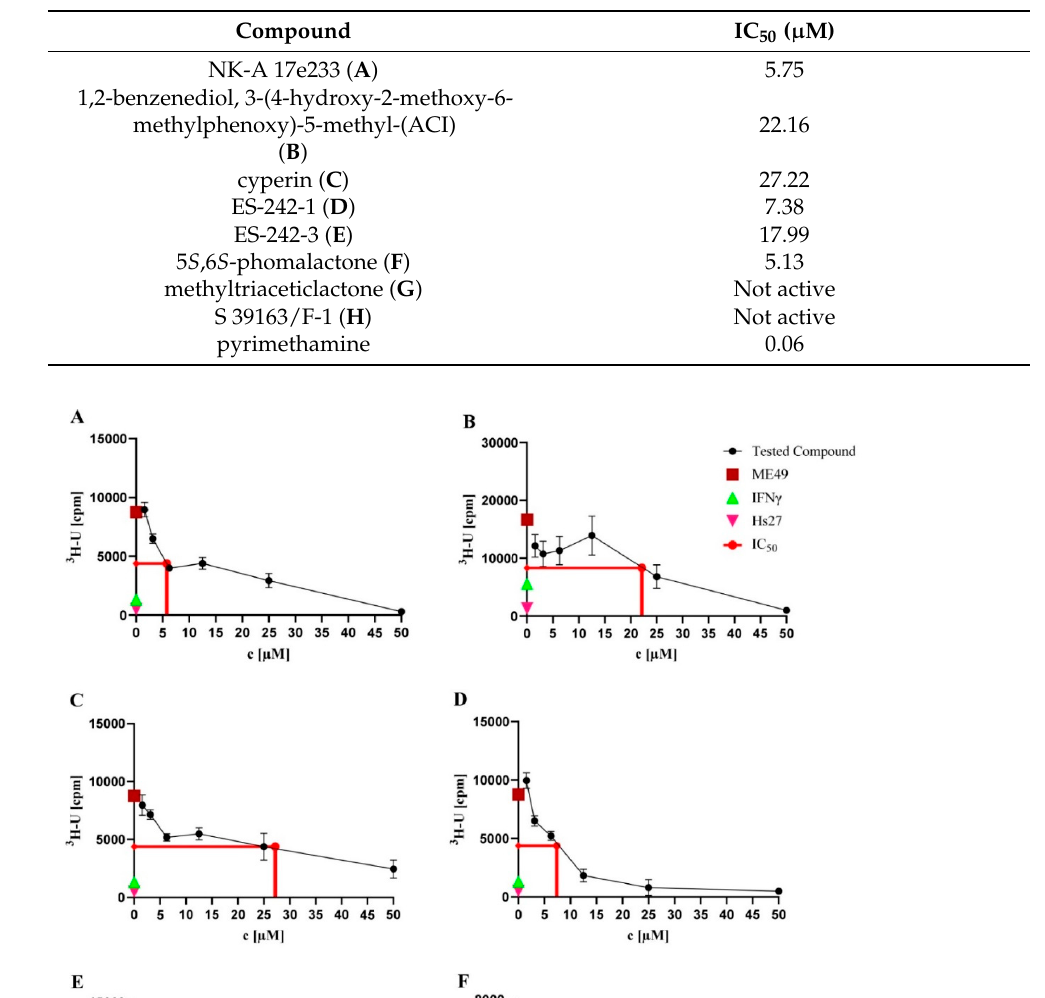
Table 1. In vitro activity (IC 50 values) of the natural compounds ( A – H ) from P. selaginellae against the T. gondii strain ME49. All experiments were conducted in triplicate.